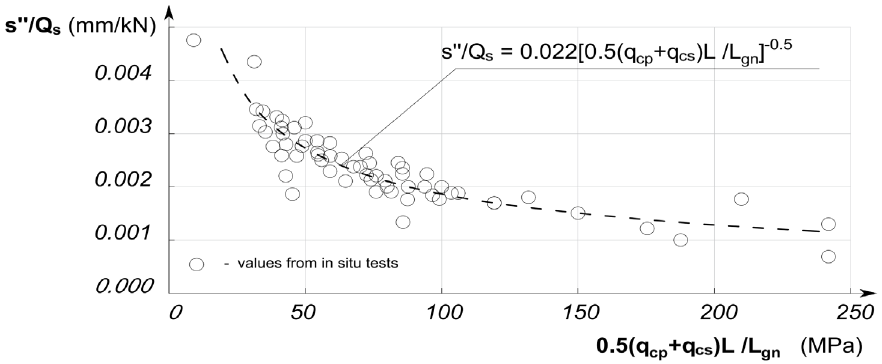
Figure 4: Dependence of ground susceptibility on parameters of the soil and pile geometry.